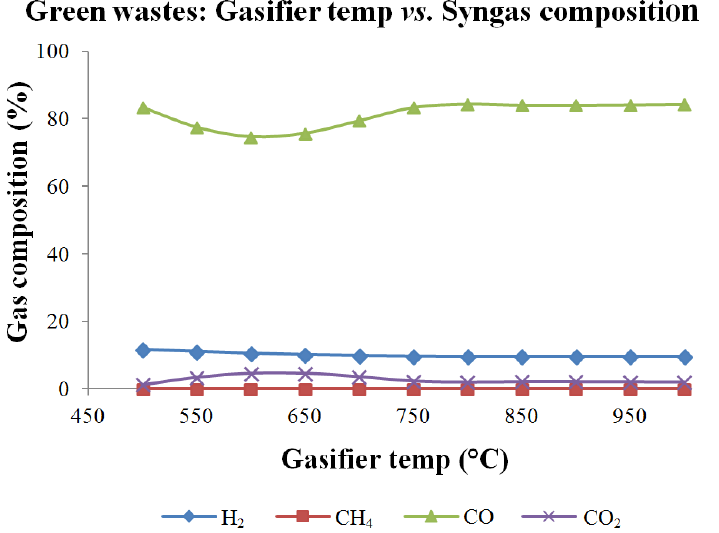
Figure 9. Effect of gasifier temperature for green wastes (air-fuel ratio: